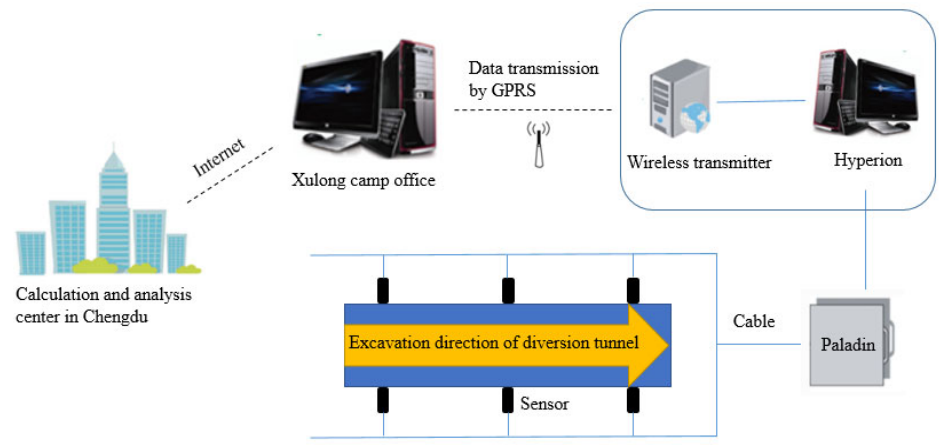
Figure 8. Network topology of the microseismic monitoring system.